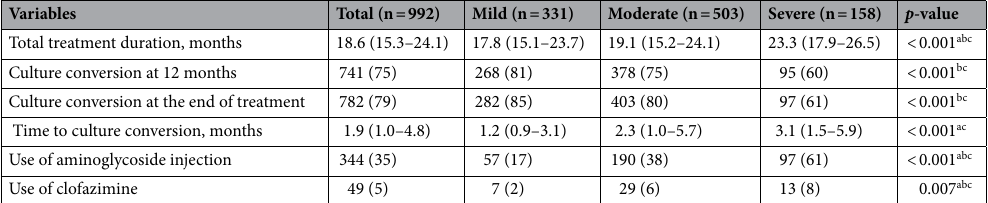
Table 2. Treatment outcome according to BACES severity. Data are presented as n (%) or median (interquartile range). BACES body mass index, age, cavity, erythrocyte sedimentation rate, and sex. a p < 0.05 with Bonferroni correction between mild and moderate groups. b p < 0.05 with Bonferroni correction between moderate and severe groups. c p < 0.05 with Bonferroni correction between mild and severe